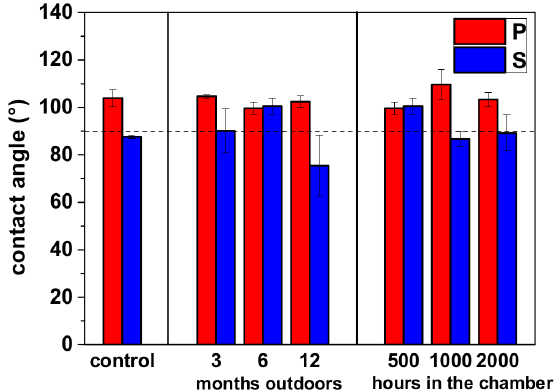
Figure 5. Water contact angle measured on the surface of anti-graffiti coated concrete after artificial and natural weathering. P, permanent treatment; S, Sacrificial treatment; control, unweathered coated surfaces.